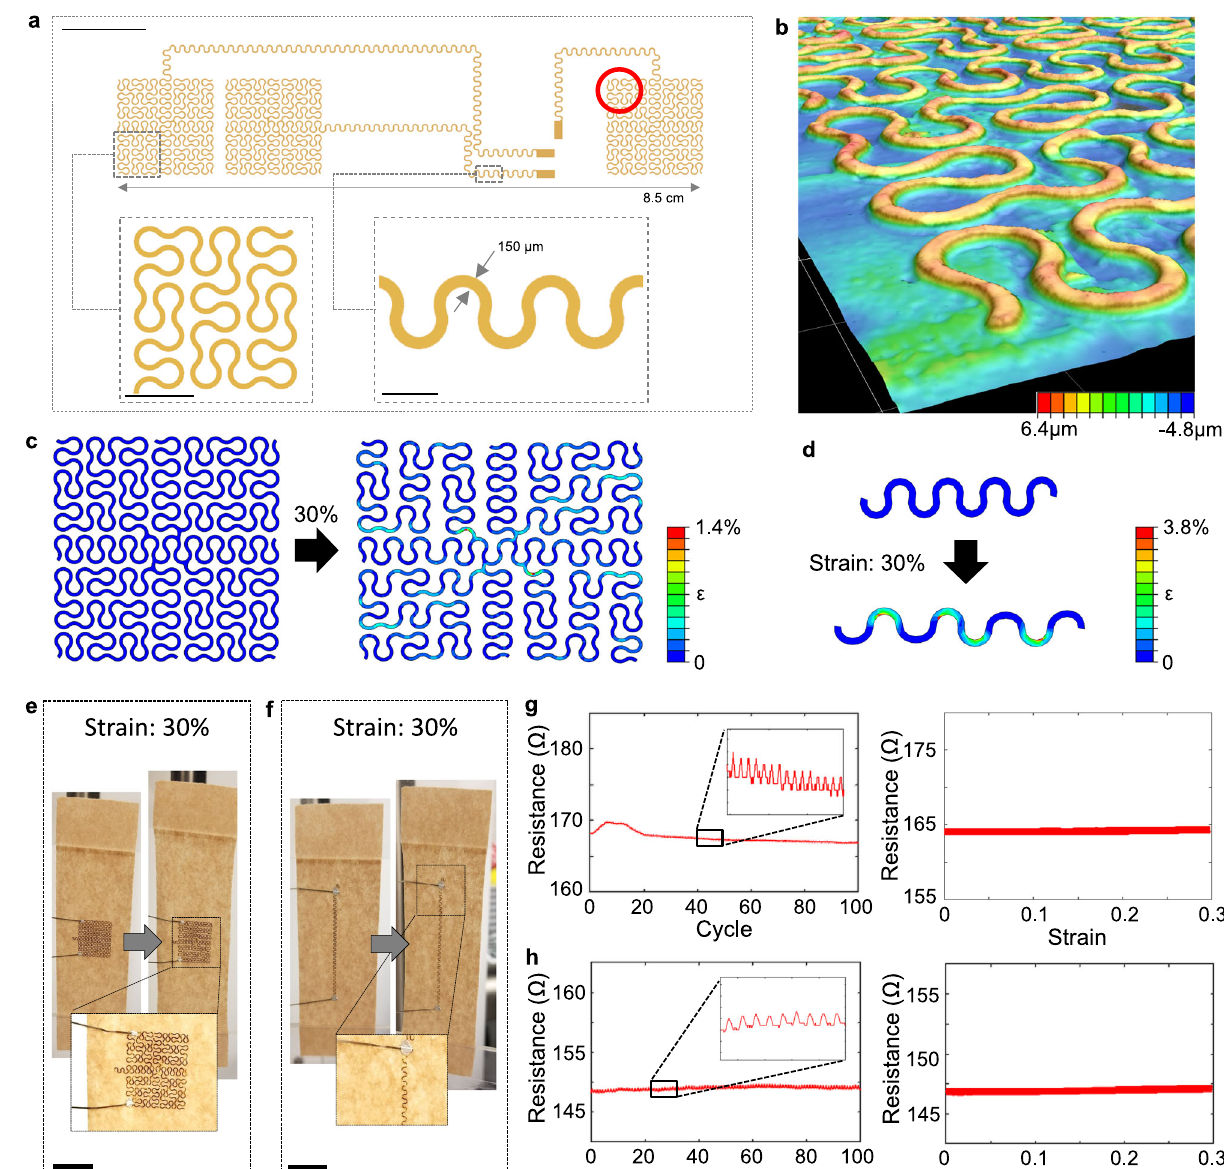
Fig. 2 Design and characterization of an SFB. a Illustration showing the dimension of an array of stretchable electrodes and interconnectors. Scale bar: 1 cm (main), 2 mm (inset-left), and 1 mm (inset-right). b 3D pro fi lometer image of the stretchable electrode in ( a ). Computation modeling results showing the electrode ’ s stretchability ( c ) and the interconnector ’ s stretchability ( d ) under 30% tensile strain. e , f Experimental validation of the stretchability of an electrode ( e ) and interconnector ( f ) during cyclic loading with 30% strain. Scale bar: 1 cm. g Measurements of electrical resistance of the electrode during cyclic loading (100 cycles; left) and 30% strain (right). h Measurements of electrical resistance of the interconnector during cyclic loading (100 cycles; left) and 30% strain